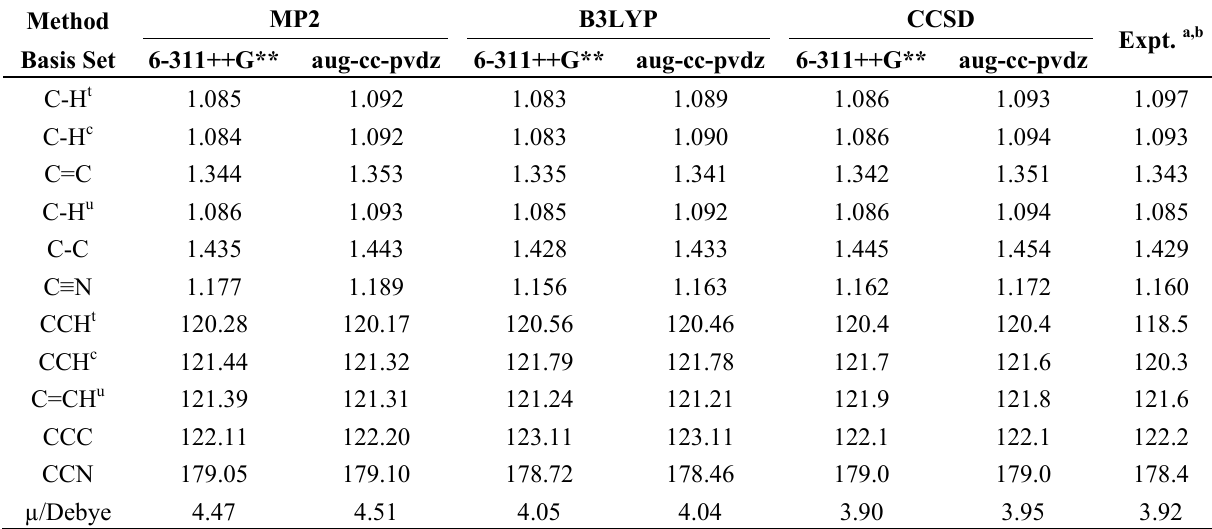
Table 2. The optimized bond lengths (Å) and bond angles (deg.) of CH using MP2, B3LYP and CCSD methods with 6-311++G** and aug-cc-pvdz basis